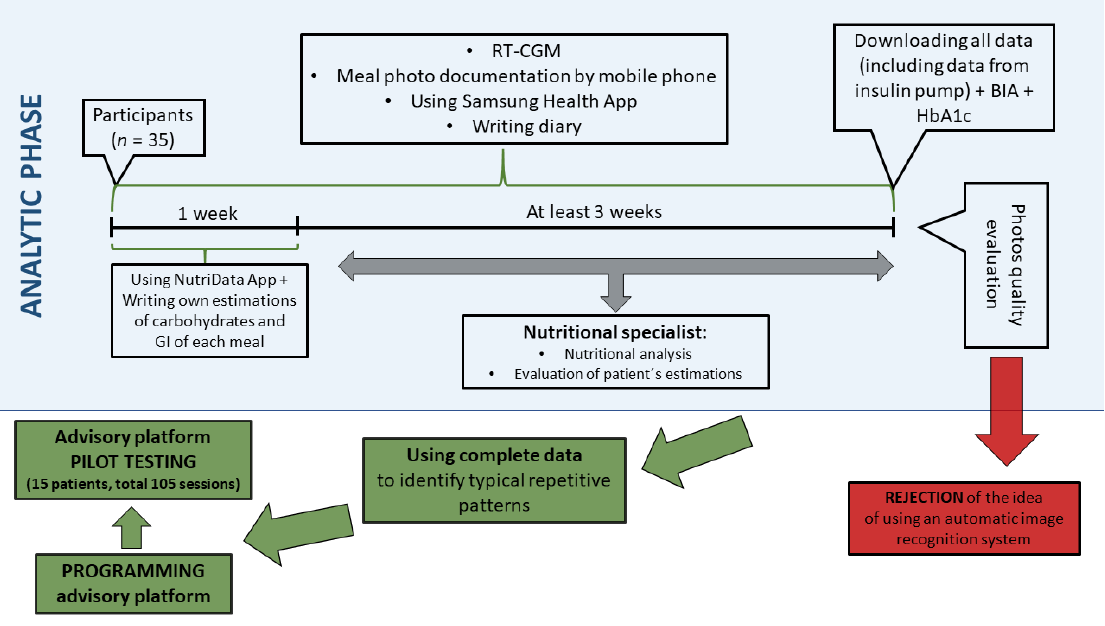
Figure 1. Study design. App—application; BIA—bioimpedance analysis; GI—glycaemic index; RT-CGM—real time continuous glucose monitoring.